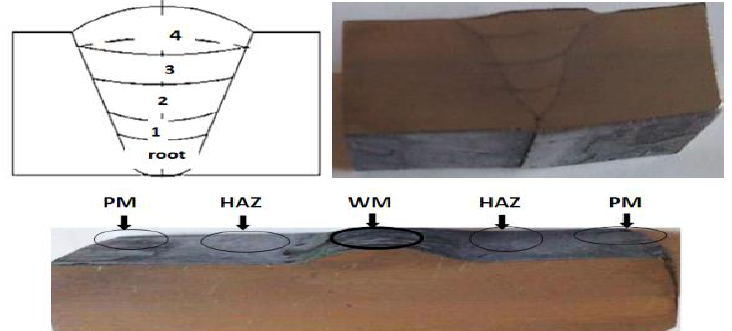
Figure 2: Sample of welded steel